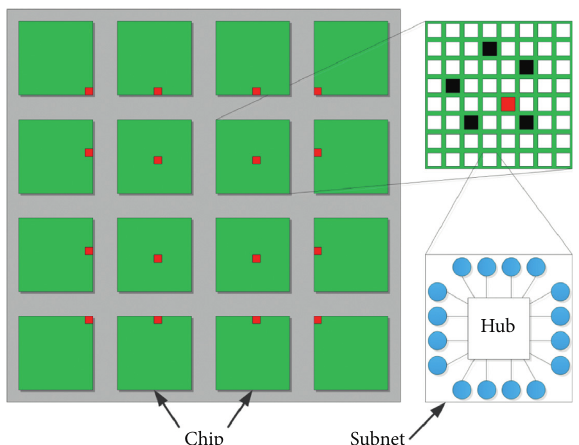
Figure 1: An overview of the position of gateways for the proposed structure. While blue circles indicate the cores, green squares are the one-kilo core chips. In addition, red, black, and white squares are the gateways, wireless hubs, and nonwireless hubs on a single chip, respectively.